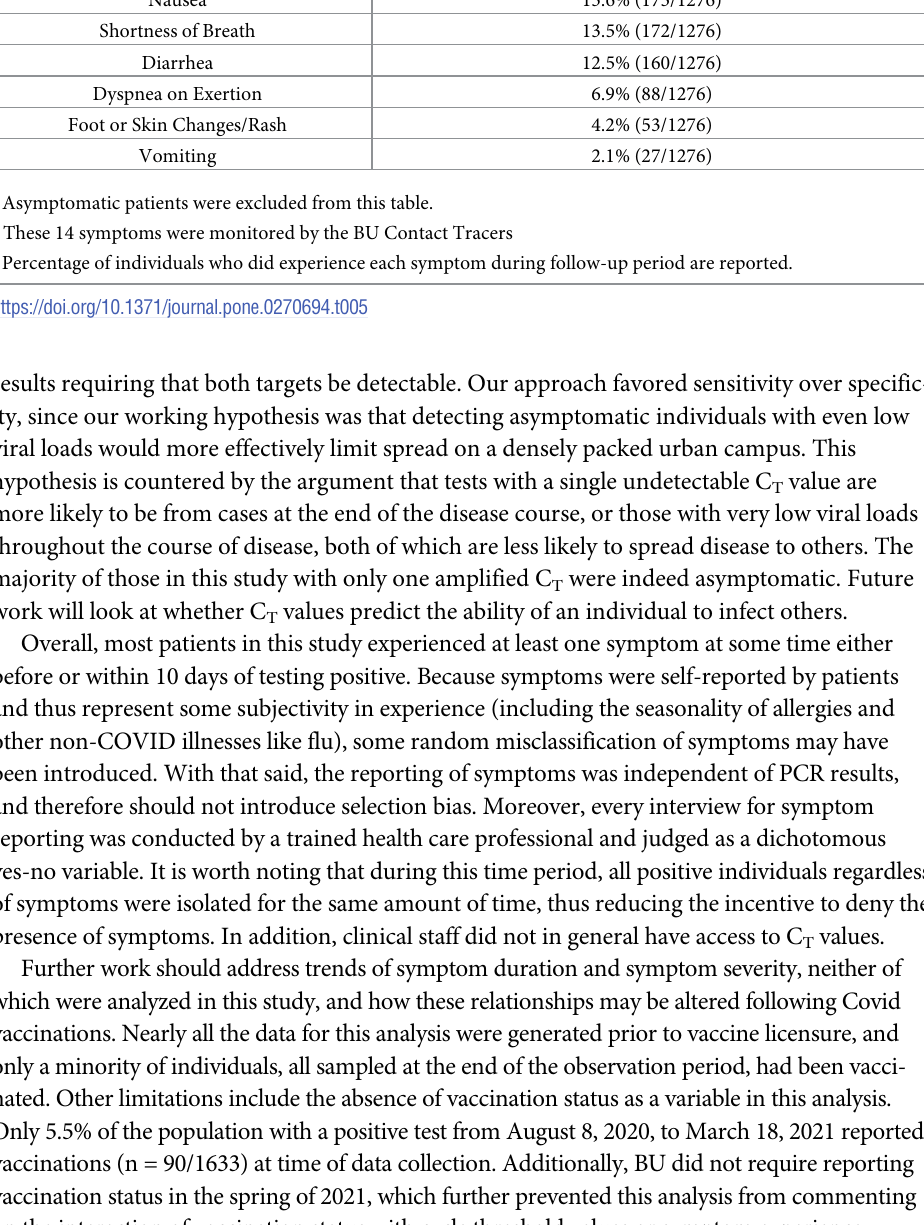
a Asymptomatic patients were excluded from this table. b These 14 symptoms were monitored by the BU Contact Tracers c Percentage of individuals who did experience each symptom during follow-up period are